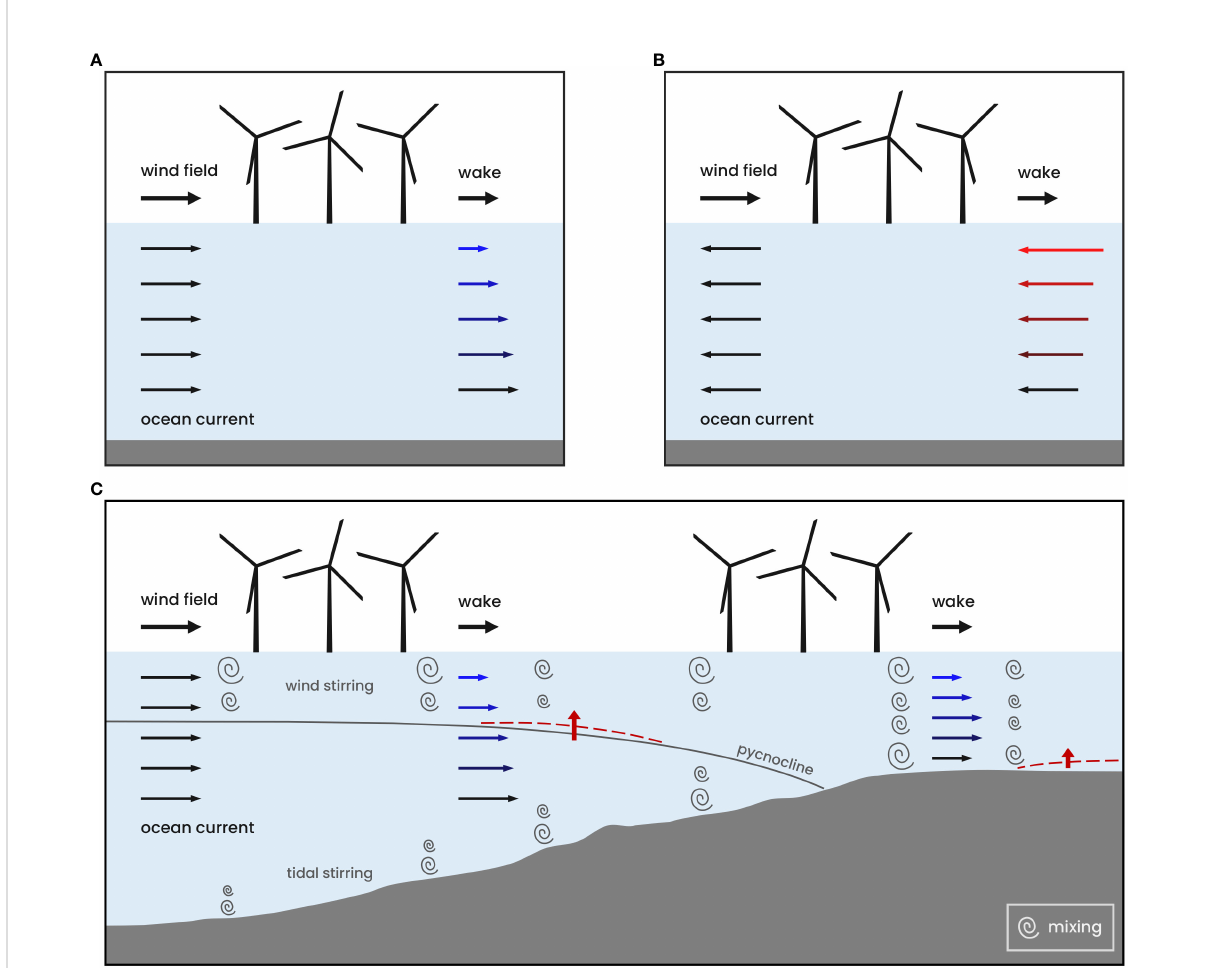
FIGURE 5 Schematic illustrations of tide-related hydrodynamic features (direct: periodic currents, indirect: mixing fronts) on the primary and secondary wake effects. (A) Primary wake effects, namely the reduction of the wind-driven ocean current, in the case of aligned wind and ocean currents. (B) Primary wake effects in the case of opposing wind and ocean currents. (C) Secondary wake effects, namely the mixing reductions and strati fi cation increase, in strati fi ed (left) and mixed (right) waters. Red dashed lines and arrows indicate the doming of the pycnocline in strati fi ed waters and the development of a pycnocline in mixed waters,